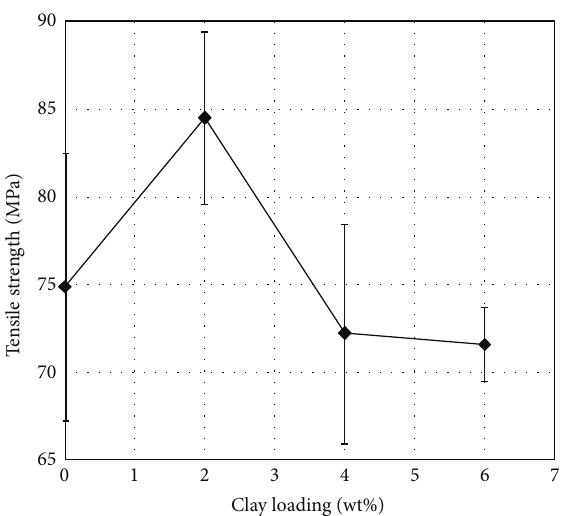
Figure 4: Effect of clay loading on the flexural strength of UP/glass fiber/clay